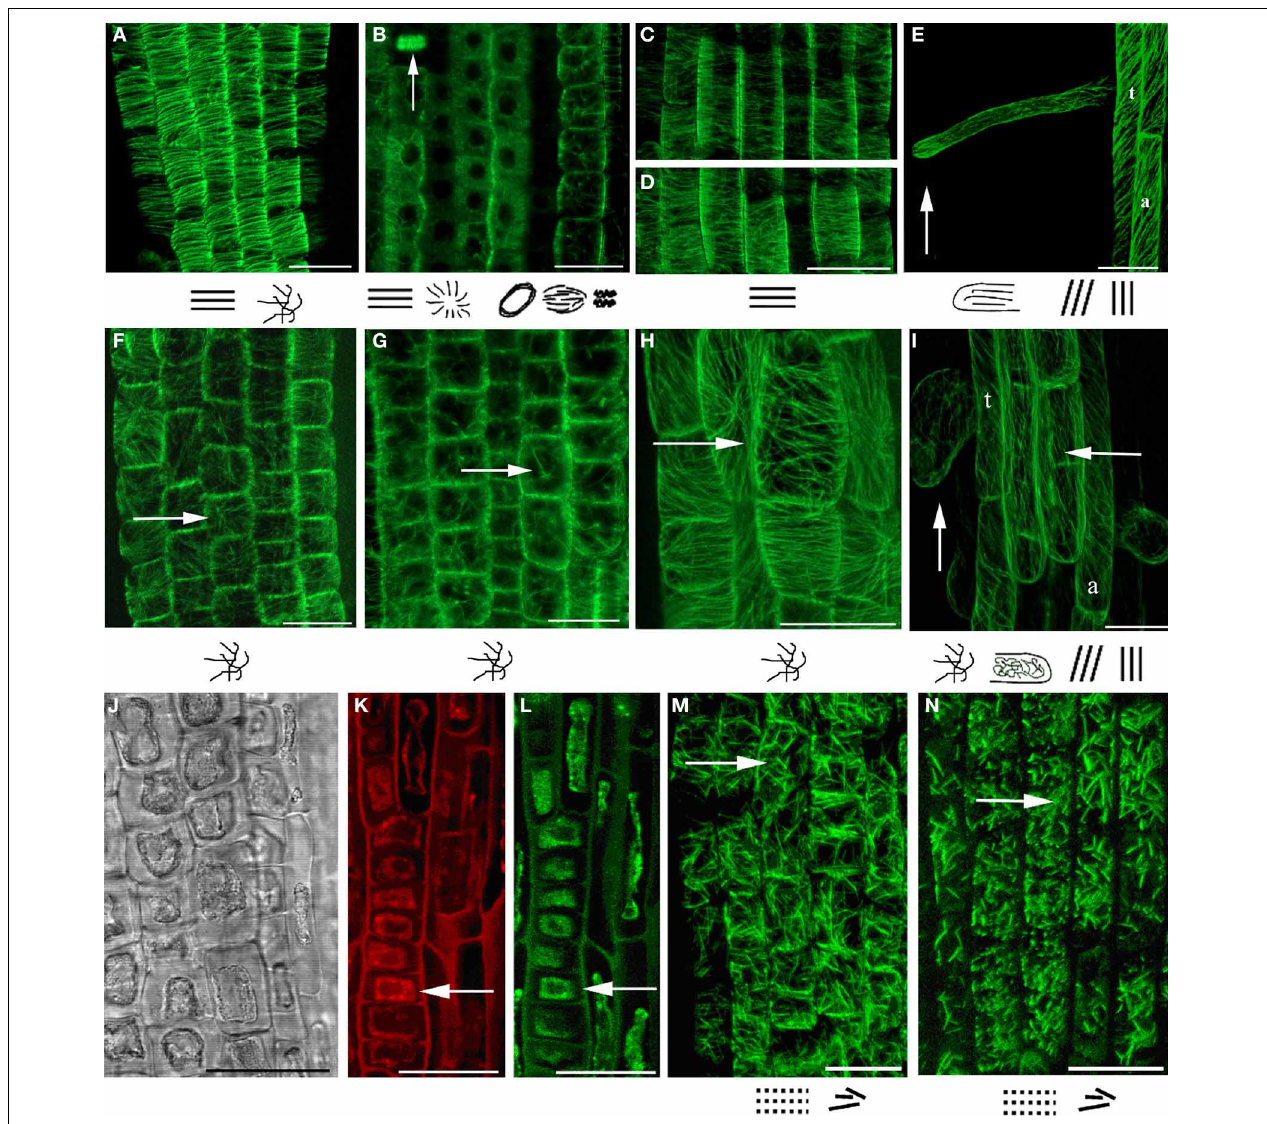
FIGURE 2 | MTs organization in epidermal cells of A. thaliana (GFP–MAP4) primary roots. (A–D) Control seedlings (L-Tyr, 200 μ M): (A) root apex; (B) meristematic zone; (C) transition zone; (D) elongation zone; (E) trichoblasts (t) and atrichoblasts (a) of the differentiation zone and root hair; (F–I) 3-NO 2 -Tyr (100 μ M, 2h): (F) root apex; (G) meristematic zone; (H) transition zone; (I) differentiation zone, 24h; (J–N) 3-NO 2 -Tyr (200 μ M, 2h): (J) general morphology of meristematic cells; (K) PI (propidium iodide) staining; (L) GFP-MAP4 signal; (M,N) MTs in epidermal cells of root apex. Images represent at least three independent experiments. Bar = 20 μ